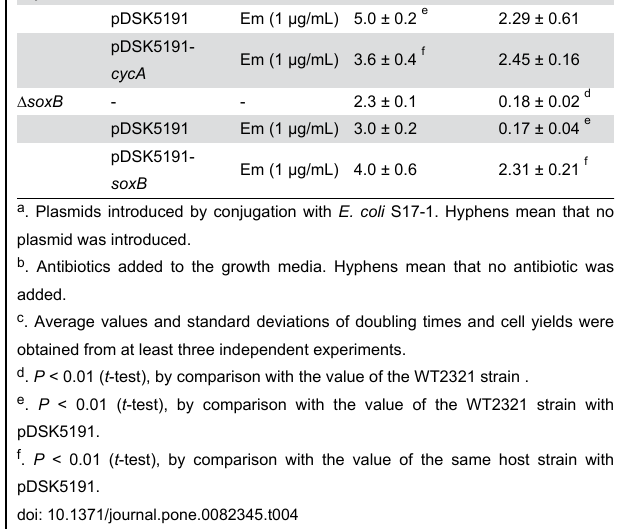
Host strain Plasmid a